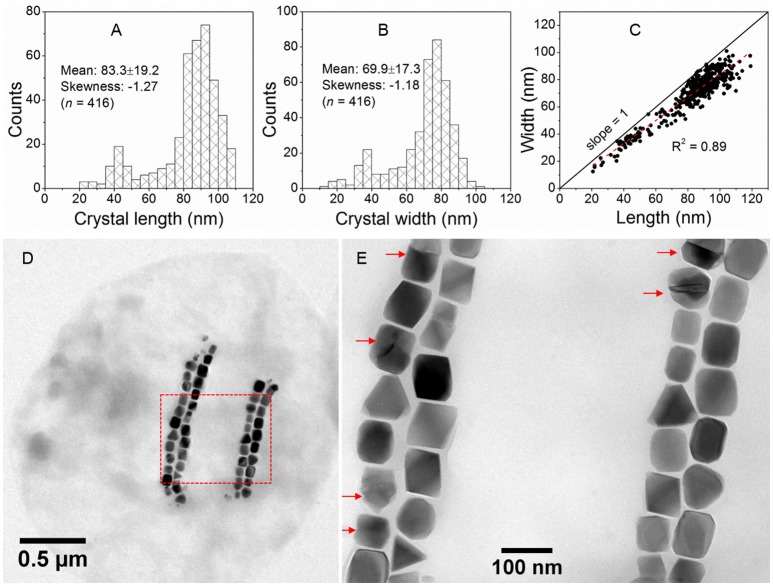
Morphological features of SHHC-1 magnetosomes. (A,B) Histograms of magnetosome length (A) and magnetosome width (B). (C) Plot of crystal length vs. width of magnetosomes showing a linear relationship between crystal length and width of SHHC-1 magnetosomes. (D) Bright-field TEM image of one of the single SHHC-1 cells. (E) Close-up on the area outlined in image (D) by a red dashed rectangle. The red arrows indicate twin crystals of magnetosomes.